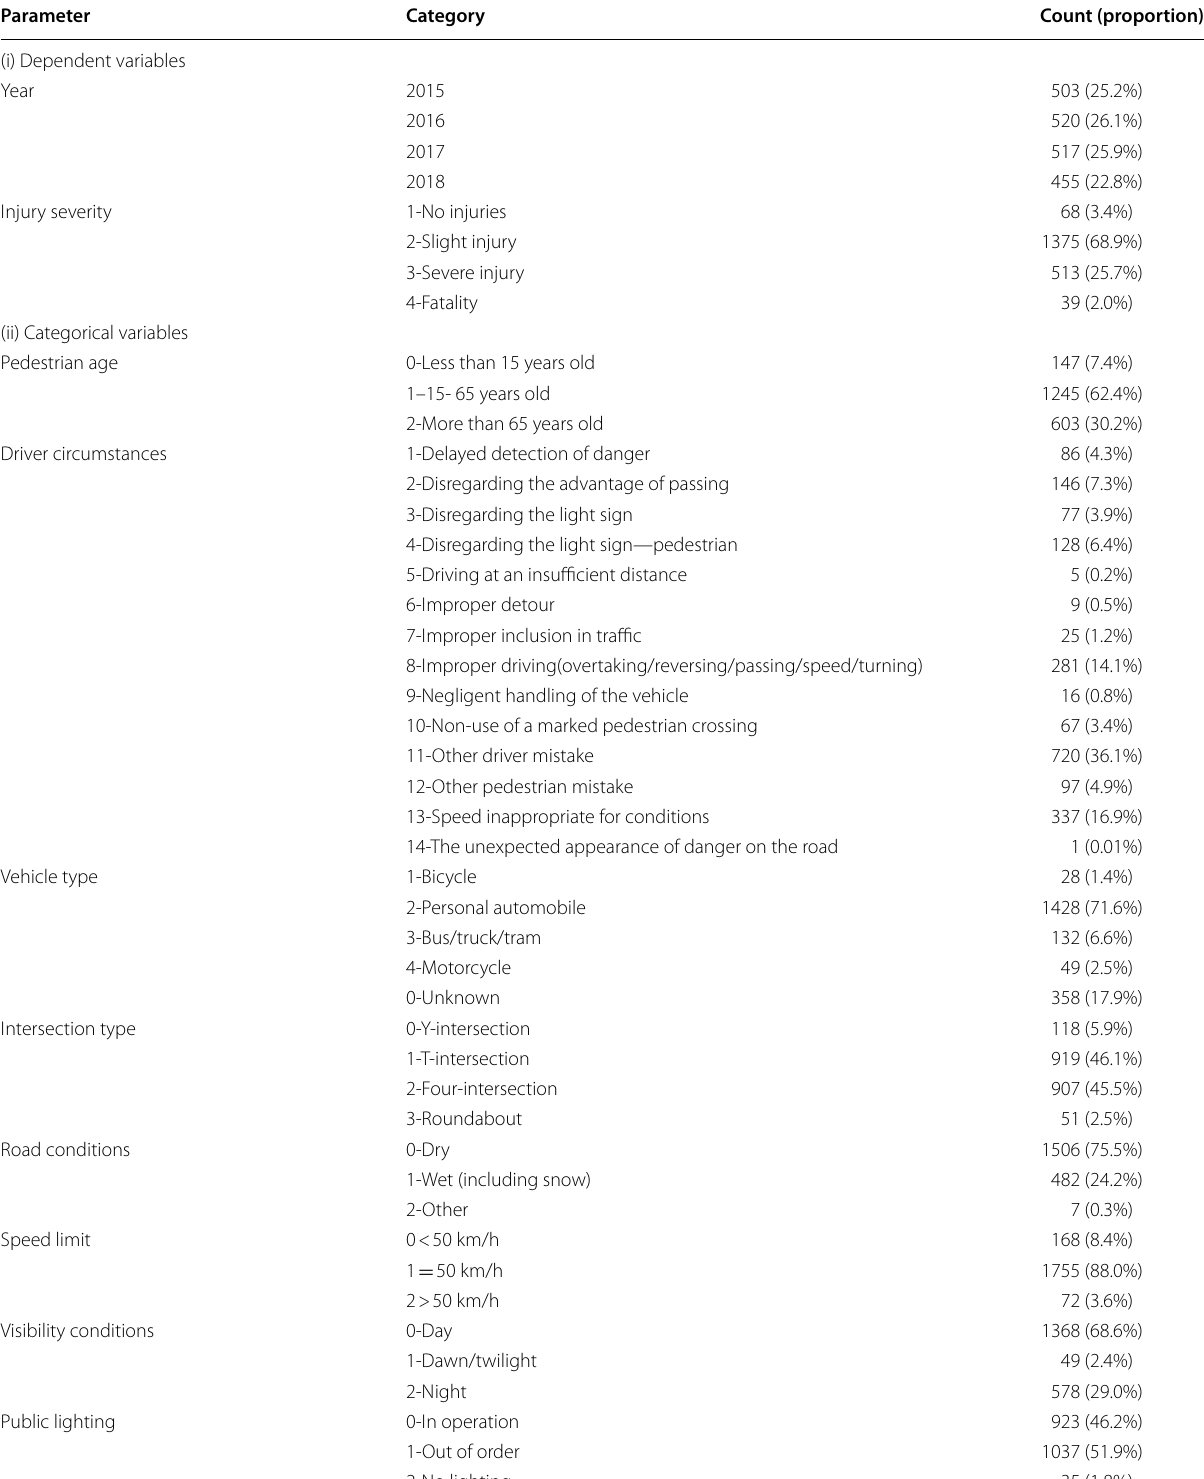
Table 1 Summary of parameter